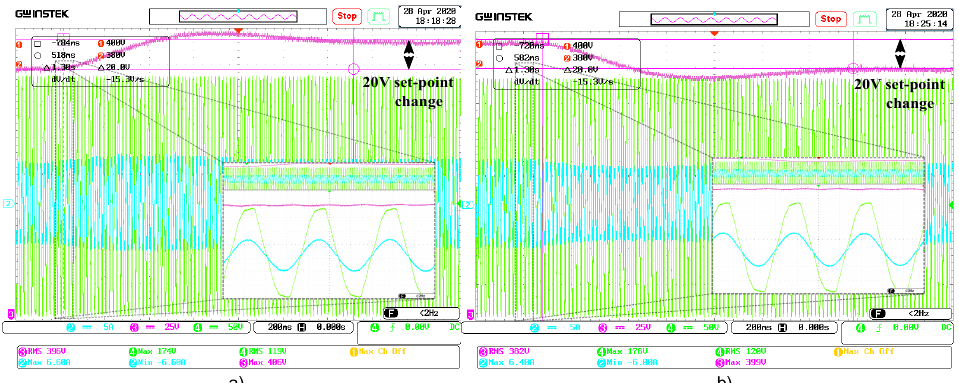
Figure 18. Experimental results with PI-SMC control for voltage set point changes: ( a ) DC voltage increases 20 V; and ( b ) DC voltage decreases 20